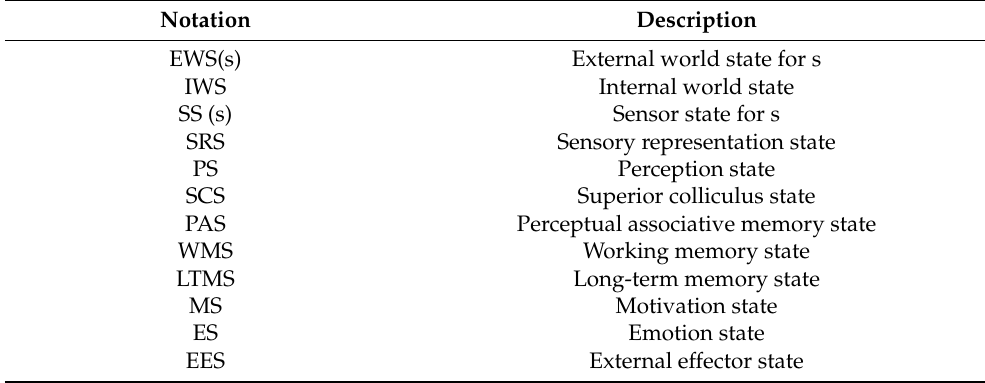
Table 2. This table defines the internal and external states of Figure 2.